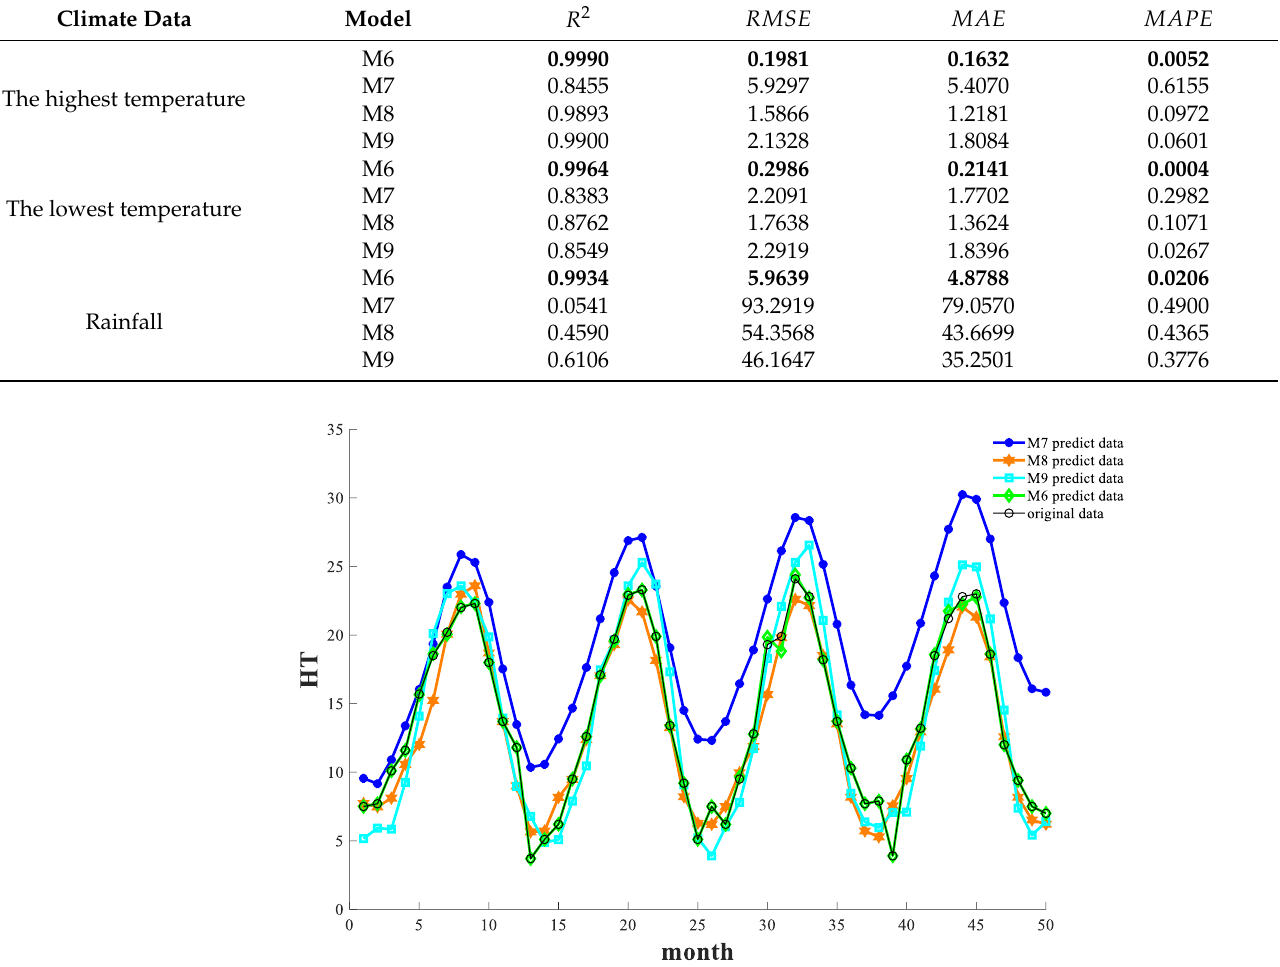
Figure 21. Predicting effect of the observed and predicted rainfall (unit: mm) using M6 – M9 mod- els. 4.5. Predicting Performance for the Proposed Model According to comparison tests for each model, we can draw the conclusion that the proposed SOPDEL model is the best model among all nine models. Therefore, further tests should be carried out to evaluate the performance of the M6 model. In this study, the monthly climate data of the target area from December 2015 to January 2020 were pre- dicted using M6, and the predicted value was compared with the real one. Based on the error between the predicted value and the real value, the corresponding evaluation sys- tem was set up as follows: Evaluation system of maximum and minimum temperature: